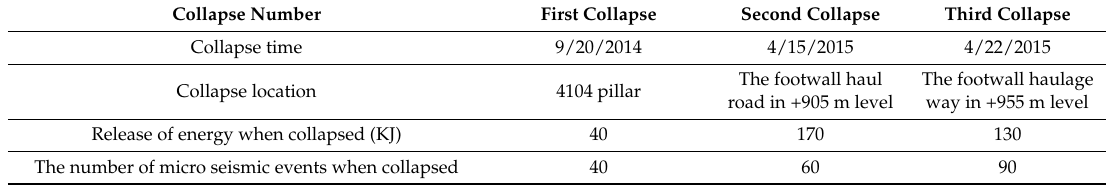
Table 3. The table of rock mass collapse time, collapse position, and the induction